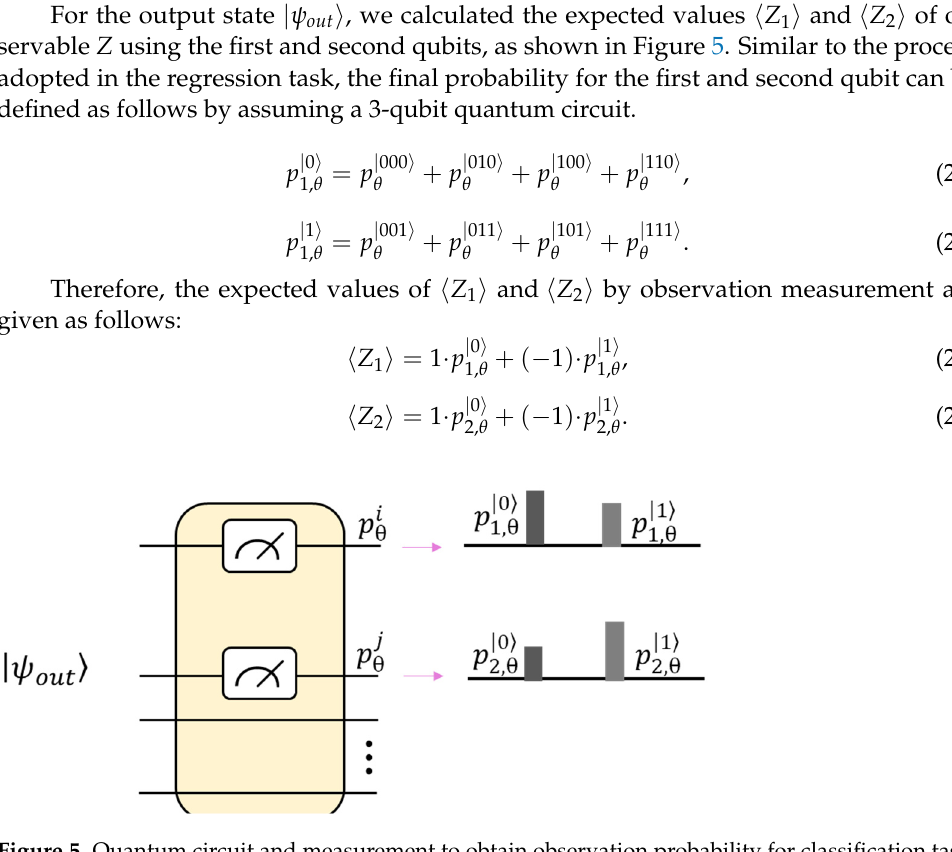
Figure 5. Quantum circuit and measurement to obtain observation probability for classification task.